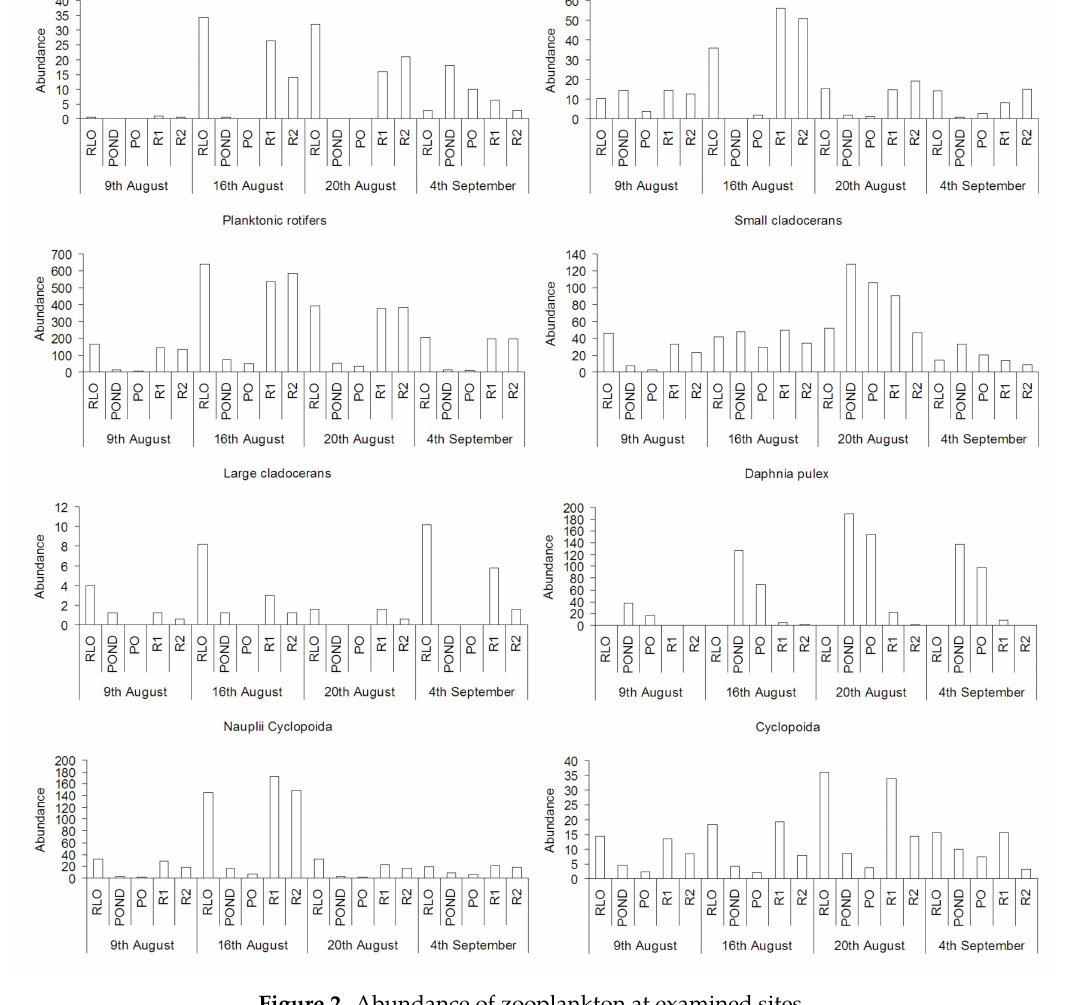
Figure 2. Abundance of zooplankton at examined